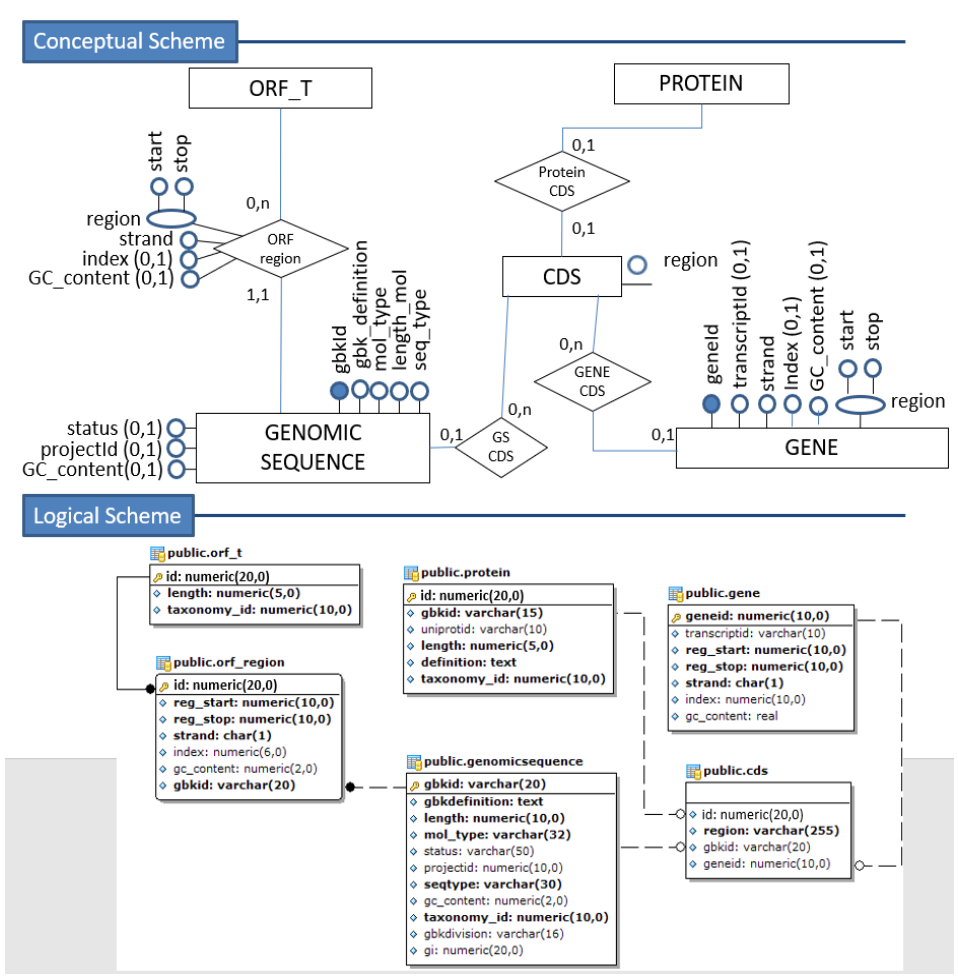
Figure 3. Conceptual to Logical Mapping—part